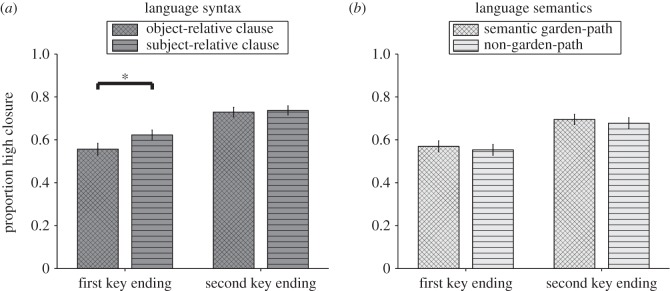
Experiment 2: closure ratings of critical trials. Participants were asked to rate their feeling of closure (y-axis) of first-key-typical endings or second-key-typical endings (x-axis). While people solved the auditory music task they were also asked to read sentences. (a) We found an influence of a syntactic manipulation on music harmony ratings. (b) A semantic garden-path manipulation was without effect. Significance levels represented as stars refer to simple main effect t-tests and do not imply significant interaction effects. Error bars=s.e.m. *p<0.05.